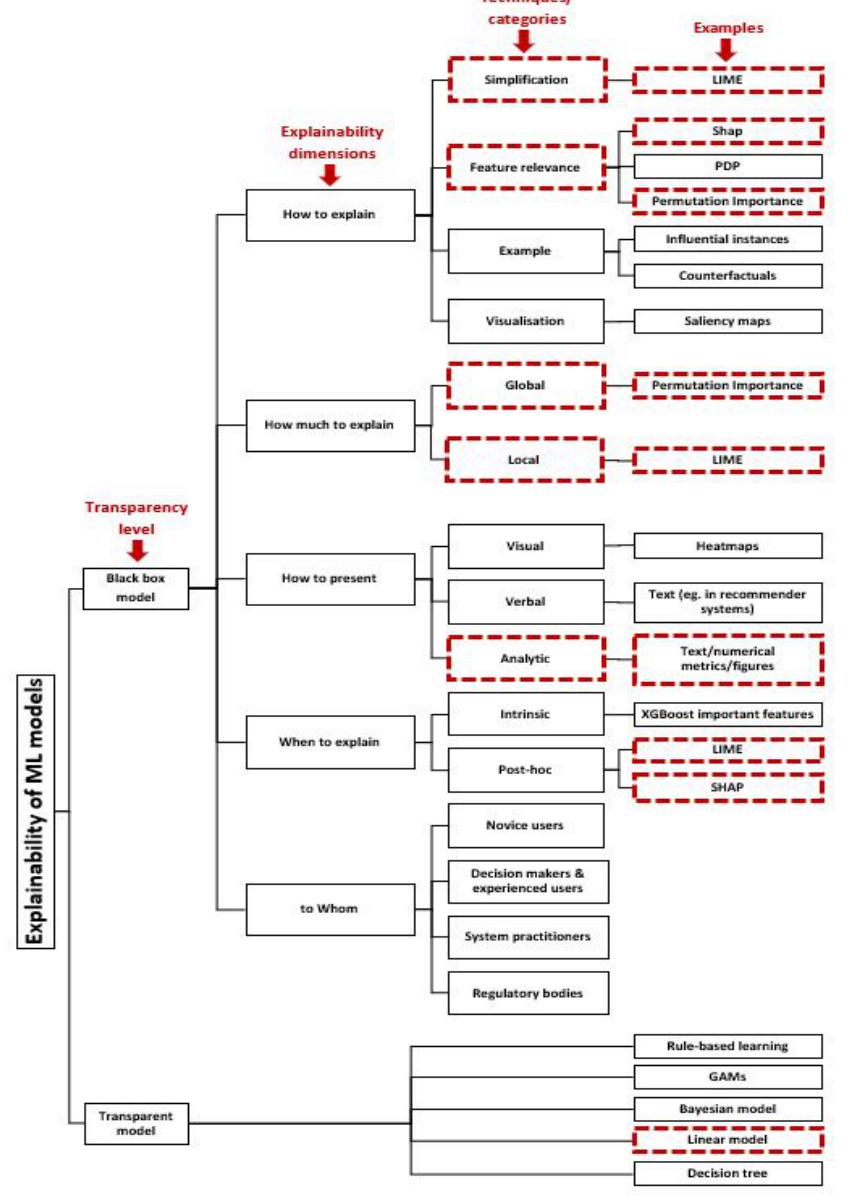
Figure 1. Explainability taxonomy in